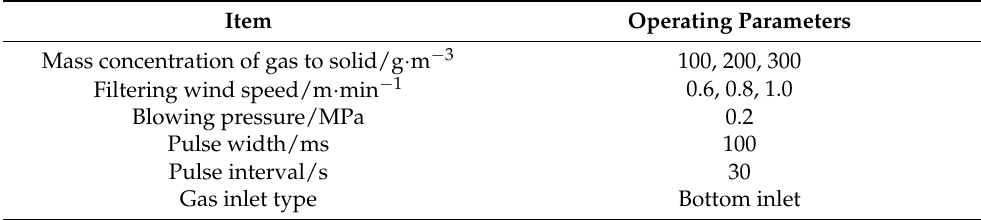
Table 3. Operating conditions of the industrial coating